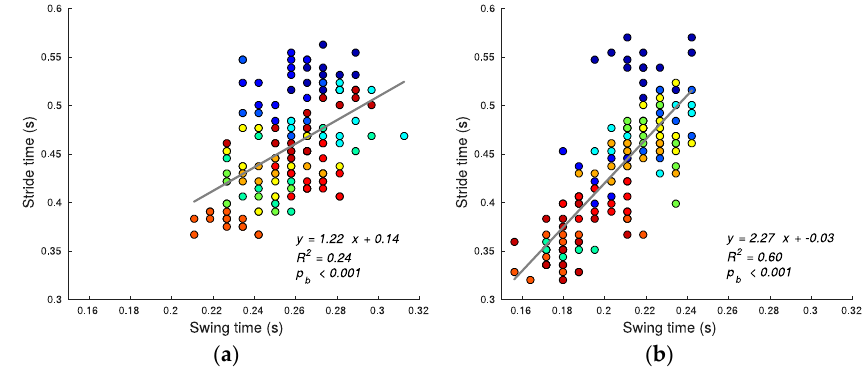
Figure 8. Swing (cid:1872) (cid:3046)(cid:3050)(cid:3036)(cid:3041)(cid:3034) and stride time (cid:1872) (cid:3046)(cid:3047)(cid:3045)(cid:3036)(cid:3031)(cid:3032) relationship for ascending ( a ) and descending ( b )